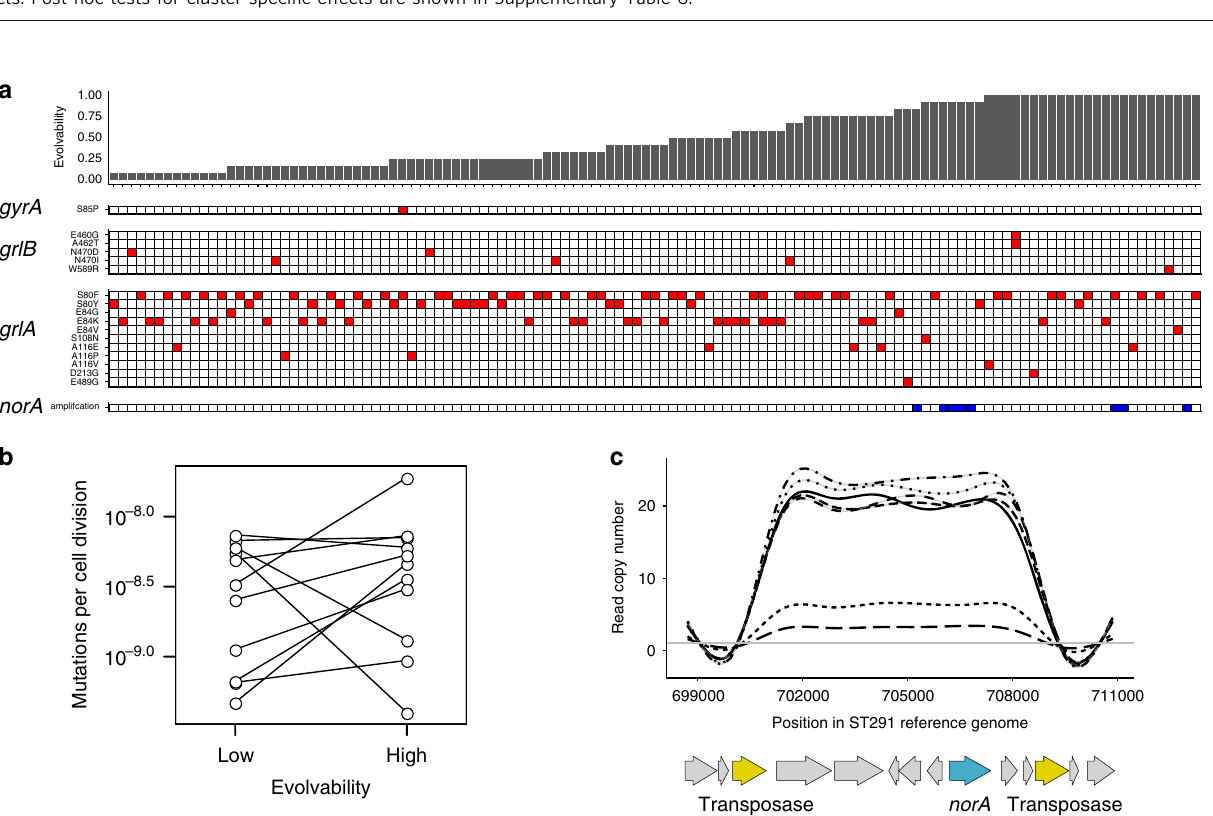
Fig. 1 Experimental evolution of cipro fl oxacin resistance. a Maximum-likelihood phylogeny of S. aureus strains included in this study. The tree was constructed using a whole-genome alignment of 222 strains mapped to the S. aureus MRSA252 reference genome and corrected for recombination. b Population growth during experimental evolution. Five heatmaps show optical density ( λ = 595) of bacterial populations at the end of each transfer. The optical density varies from low (no growth, OD 595 < 0.08, black) to high density (high growth, OD 595 > 1, bright yellow). In each heatmap, the columns correspond to 12 replicate populations, and the rows correspond to 222 strains. c The correlation of population survival and intrinsic resistance in 14 phylogenetic clusters. Each data point represents one strain where population survival is the proportion of replicate populations that evolved resistance, and intrinsic resistance is IC 50 (half growth inhibition dose) of a parental strain. Colour and shape for each strain indicate MLST (multilocus sequence type). An open circle is shown when MLST could not be determined. 222 strains were assigned to 14 phylogenetic clusters based on a genetic distance matrix obtained from the phylogenetic tree in ( a ). The black curves show a model fi t for the logistic regression between survival and intrinsic resistance across all 222 strains (the same for all clusters, GLM: χ 2 = 393.93, d.f. = 1, residual d.f. = 220, p < 2.2e − 16), and the red curves show cluster-speci fi c effects. Post hoc tests for cluster-speci fi c effects are shown in Supplementary Table 6.